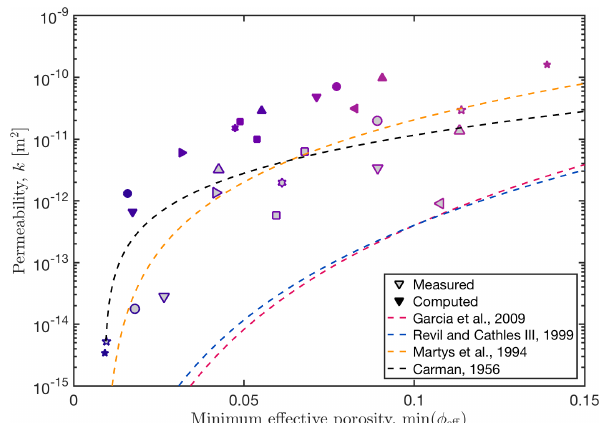
Figure 5. Computed and measured permeability against minimum effective porosity. Symbols of the same shape and colour represent the same sample. Samples with a grey face represent measured val- ues, whereas colour-only symbols stand for computed subsamples. The computed permeabilities represent the geometric mean values of all subsamples. To verify existing permeability parameteriza- tions, we plotted the relations of Revil and Cathles (1999), Gar- cia et al. (2009), Carman (1956), and Martys et al. (1994) against the experimental and numerical permeabilities. Note that estimated errors for the experimental permeability measurements (Table 1a) are smaller than the displayed symbols. Some subsamples with low effective porosity did not show a continuous pathway throughout the subsample, and thus we assumed a very low permeability of 10 − 20 m 2